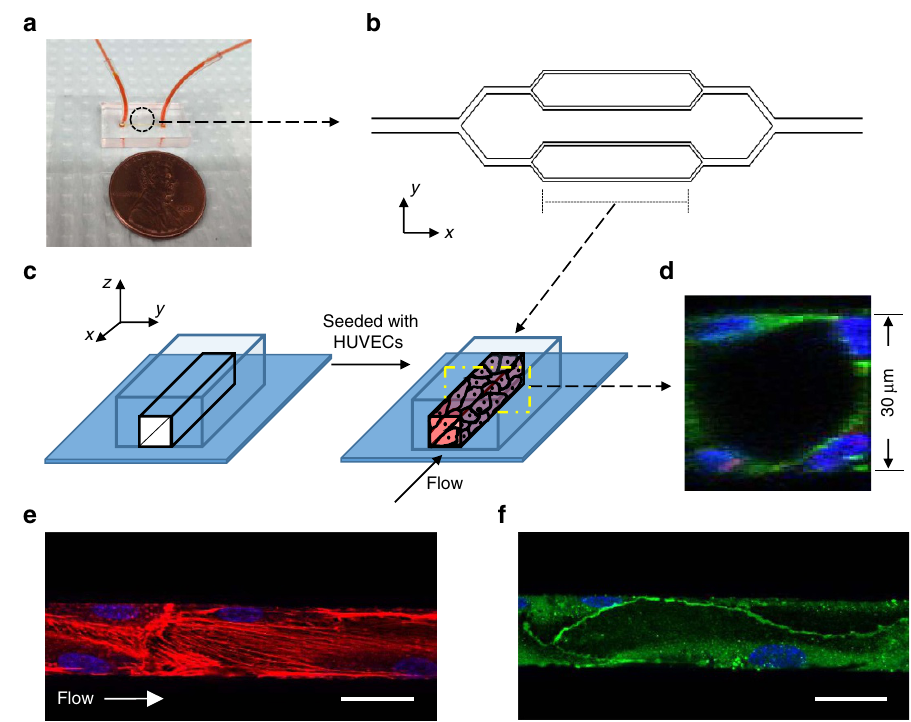
Figure 3 | Engineered in vitro endothelialized microfluidic channels. ( a ) Macroscopic view of a PDMS microdevice filled with red food colour. ( b ) CAD-based geometric pattern of the microfluidic system. The smallest channels in this pattern are 30 m m in width, and the height of the channels after fabrication is also 30 m m. ( c ) A schematic diagram showing the process of ‘endothelization’ of the microfluidic channel. The endothelialized channel is maintained under constant, physiologic flow conditions. ( d ) A representative confocal image of the cross-section of the smallest channel after endothelial cells reach confluency (blue, nuclei; green, actin). ( e ) In the engineered endothelium, F-actin fibres (red) were localized at the cell–cell interface and stress fibres (red) are aligned with the flow (blue, nuclei). ( f ) The engineered endothelium comprises continuous adherens junctions, as shown on anti-VE-cadherin staining (green). Scale bar, 30 m